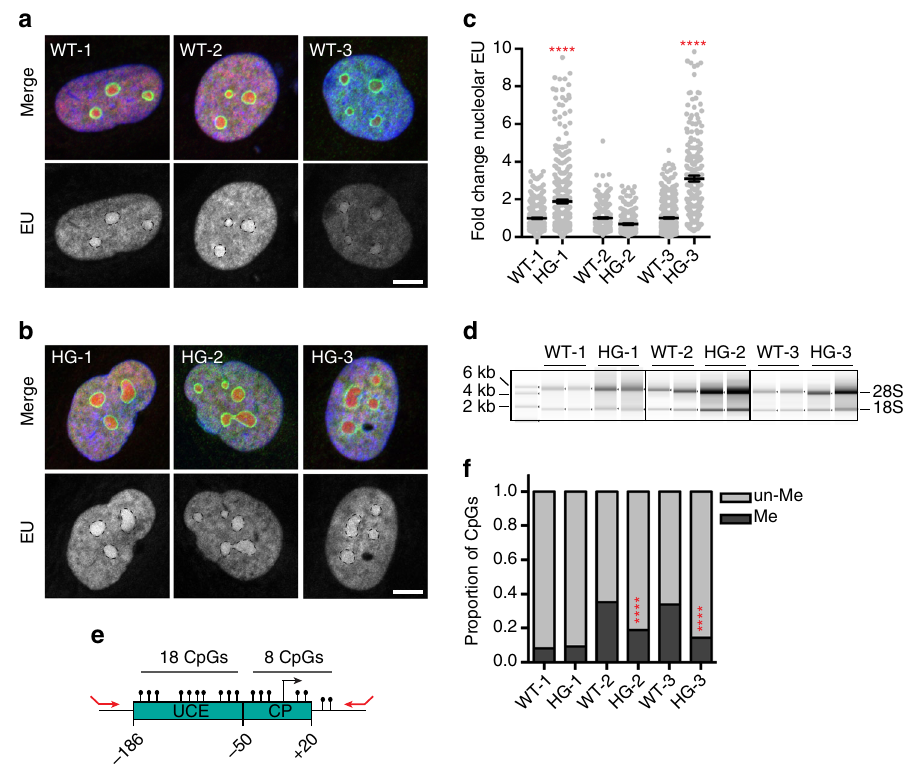
Fig. 3 Increased rDNA transcription in HGPS. a , b Visualization of rRNA synthesis by a 4-h pulse of EU labeling ( magenta ) followed by immunostaining for nucleolin ( cyan ) in WT a or HGPS b fi broblasts. Scale bar , 10 μ m. c Quanti fi cation of EU fl uorescence intensity per nucleolus. **** indicates p < 0.0001 determined by t -test. N > 142 nucleoli analyzed per condition in two independent experiments with two technical replicates. Black bars indicate mean ± SEM. d Total RNA extracted from equal numbers of WT and HGPS fi broblasts. In all, 28 S (5 kb) and 18 S (1.9 kb) rRNAs are indicated. Representative images from one of three independent experiments shown. e Schematic map of the rDNA promoter. UCE, upstream control element; CP, core promoter. Black knobs , CpG methylation. In all, 18 CpGs in the UCE and 8 CpGs in the CP were analyzed. Red arrows indicate primers used for bisul fi te sequencing. f Quanti fi cation of total CpG promoter methylation on rDNA promoters in WT and HGPS fi broblasts. See also Table 1. In 2 of 3 pairs, methylation is signi fi cantly decreased in HGPS (****, p < 0.0001, determined by χ 2 -test). N > 270 CpGs analyzed per condition in two independent experiments Table 1 Analysis of rDNA promoter methylation Sample